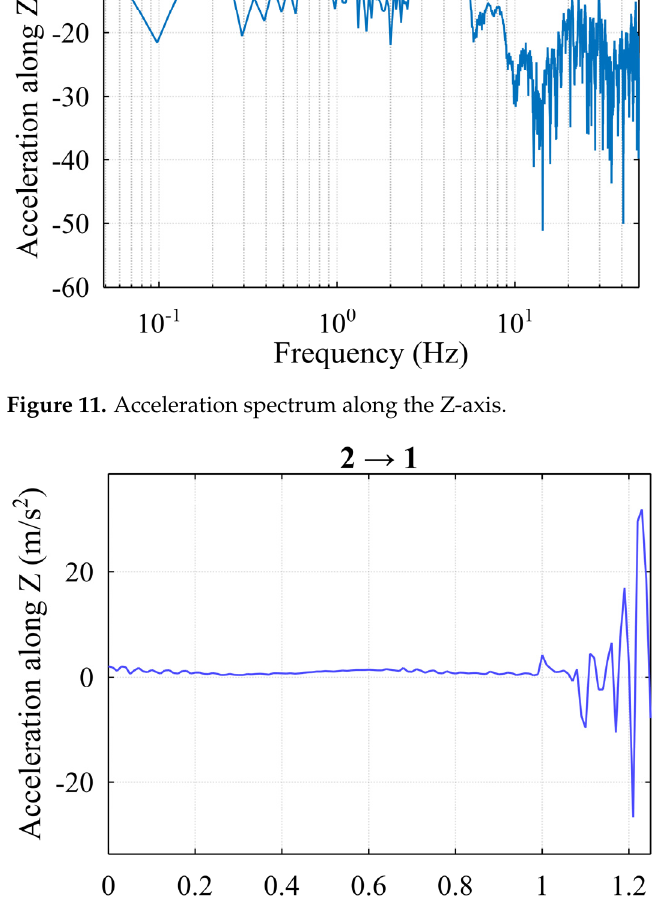
Figure 12. Shock moments along the Z-axis during movement in the hull of the ship.